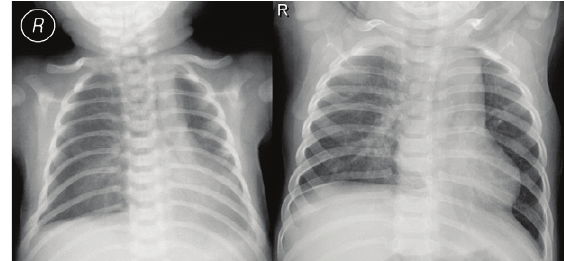
Figure 1. Chest radiograph at initial presentation shows extensive bowel gas in the thoracic cavity, consistent with congenital diaphragmatic hernia.